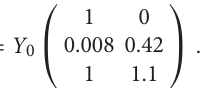
FIGURE 7 | Predictions for LFV Higgs boson decays using Equation (28) in a seesaw model with two pairs of Majorana neutrinos with masses M R defined in Equation (33). In the left, both neutrinos have Yukawa couplings equal to 1 with electron and tau leptons, and 0 with muons. In the right, we exchange the roles of electrons and muons. Purple shadowed area is disallowed by global fit constraints in Equation